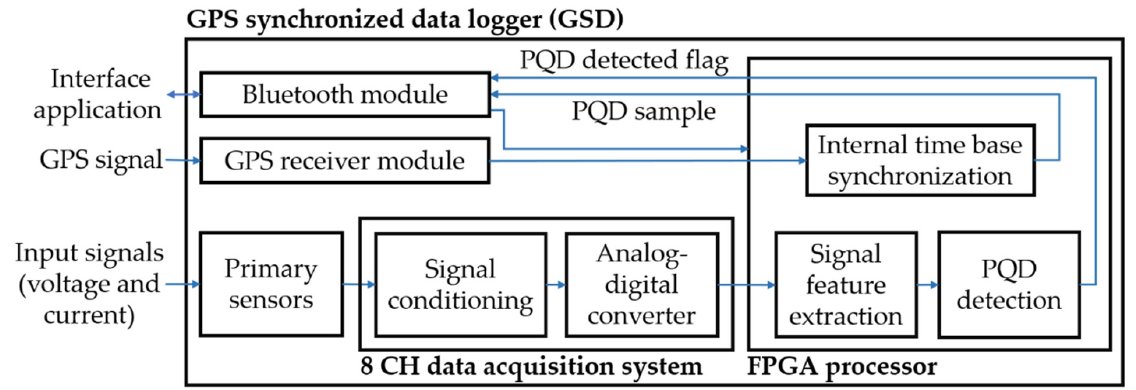
Figure 8. Diagram of disturbance propagation monitoring procedure using GPS-synchronized data loggers called GSD and full parameterized PQD model.